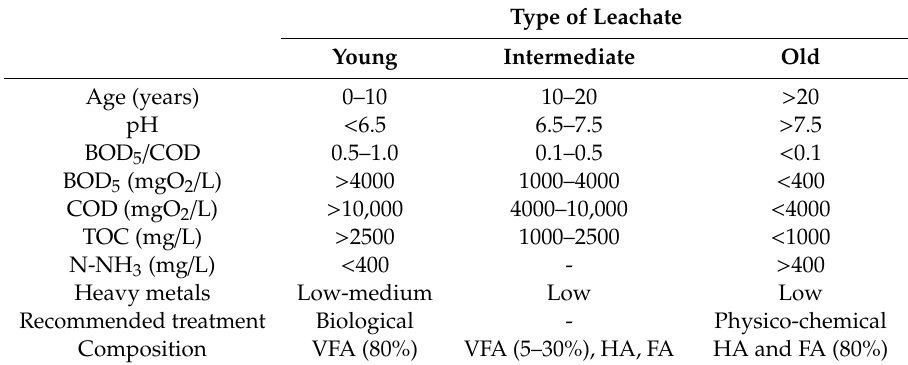
Table 1. Characteristics of landfill leachates according to landfill age